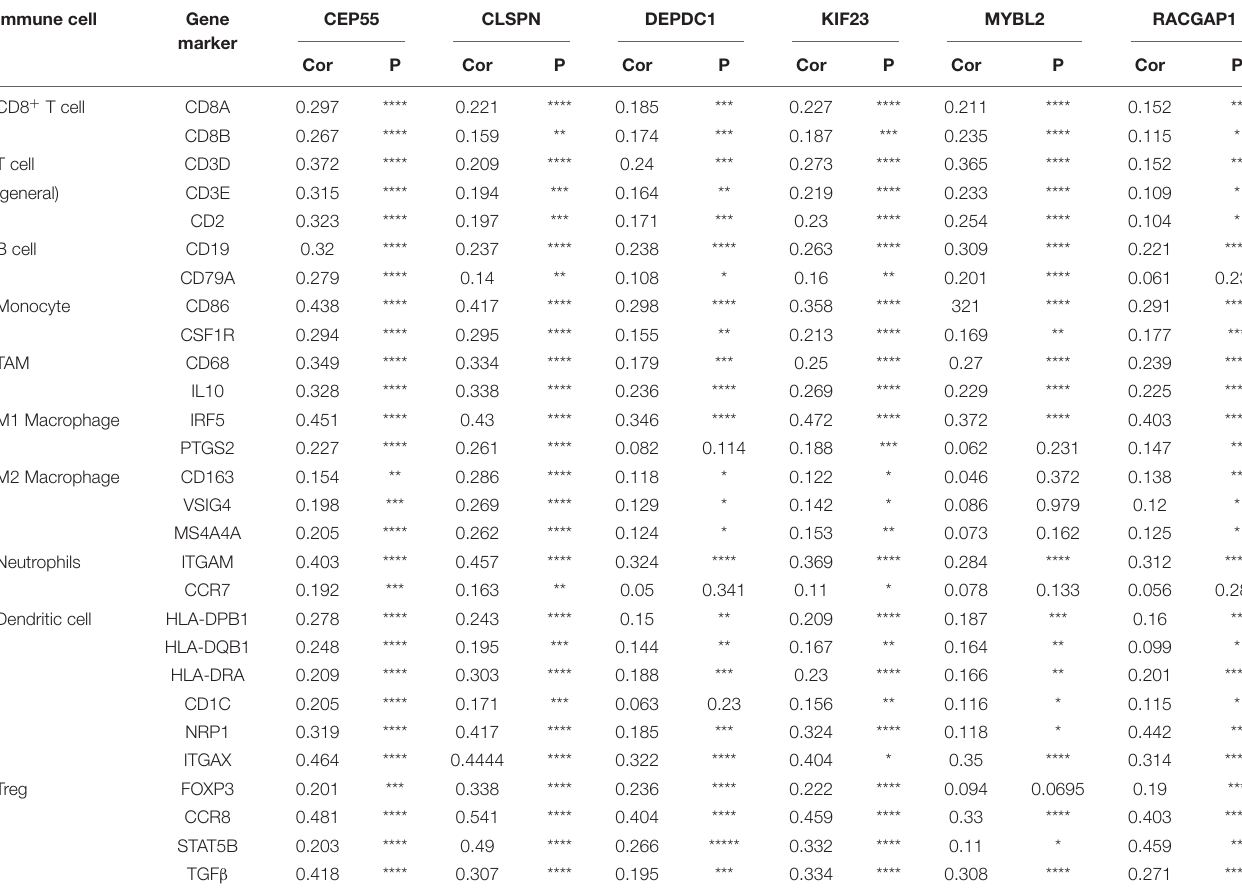
TABLE 1 | The correlation between six hub genes and related genes and markers of immune cells for HCC in TIMER. Immune cell Gene CEP55 marker